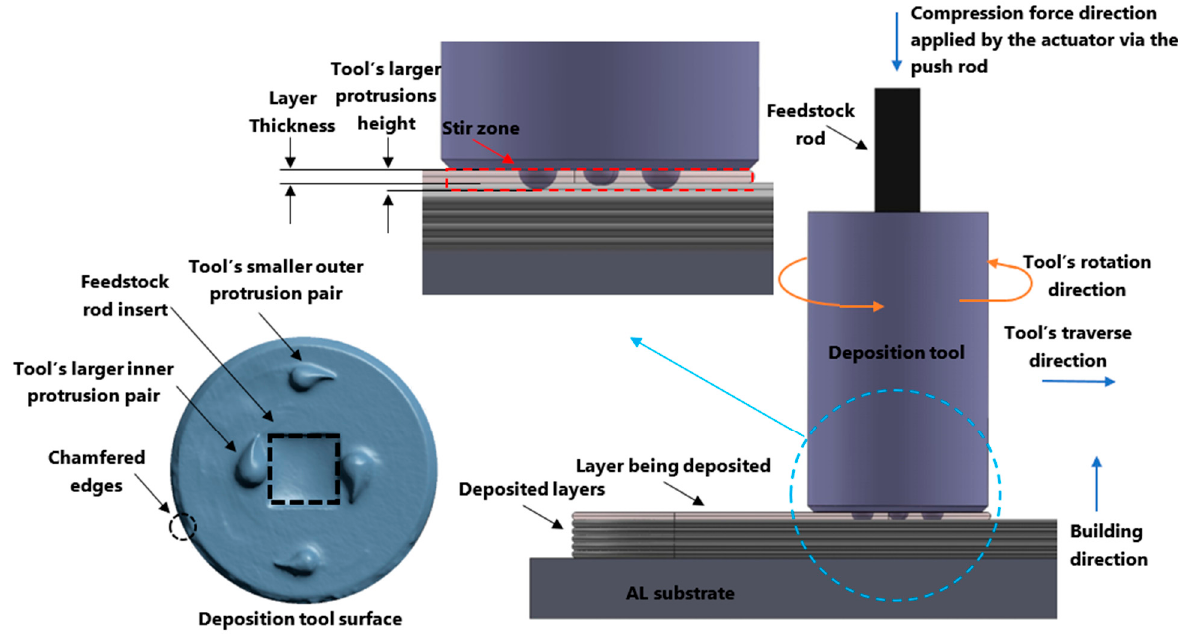
Figure 1. AFSD deposition mechanism and the deposition tool design.